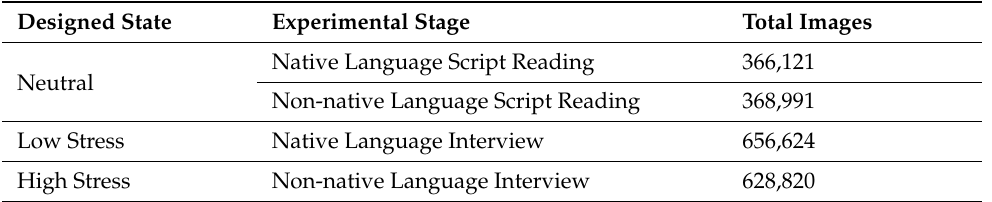
Table 1. Number of images acquired at each stage of the database